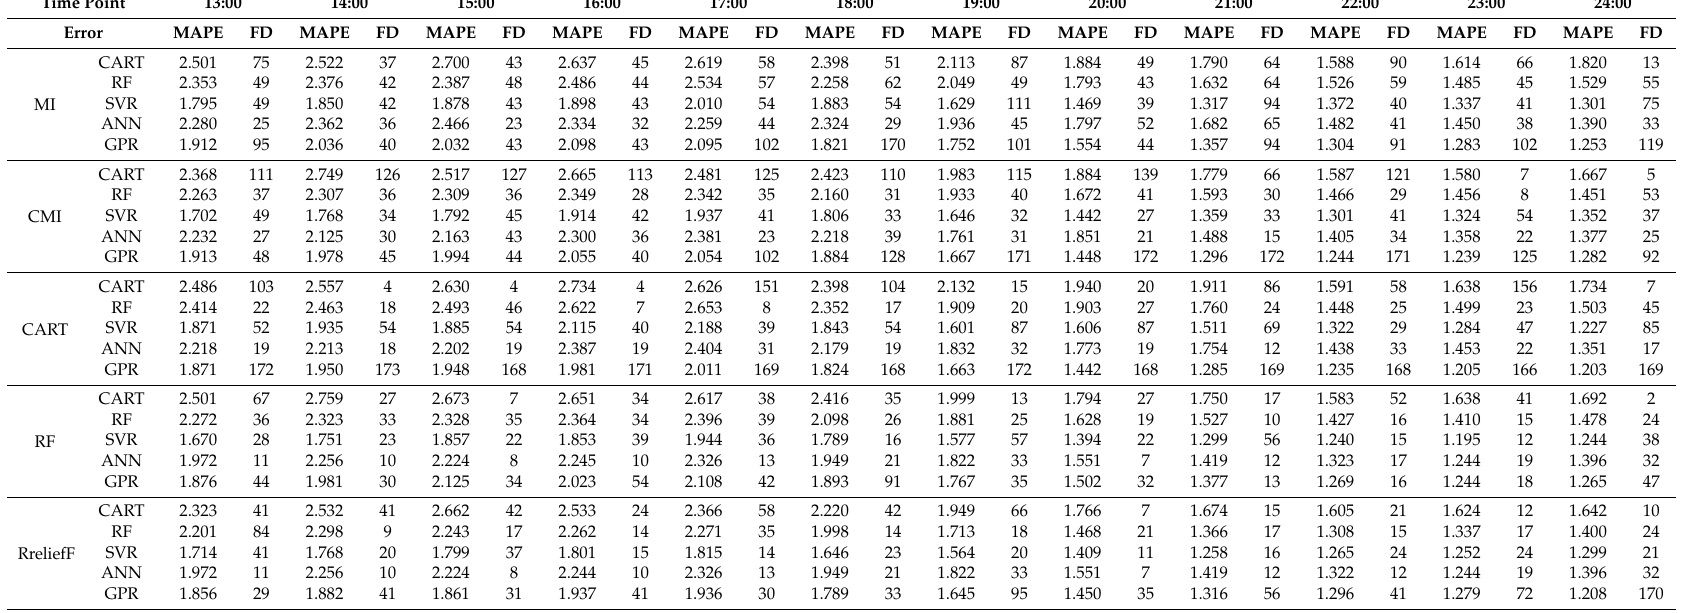
Table A4. Optimal feature subset construction of different hours from 13:00 to 24:00 with different methods for